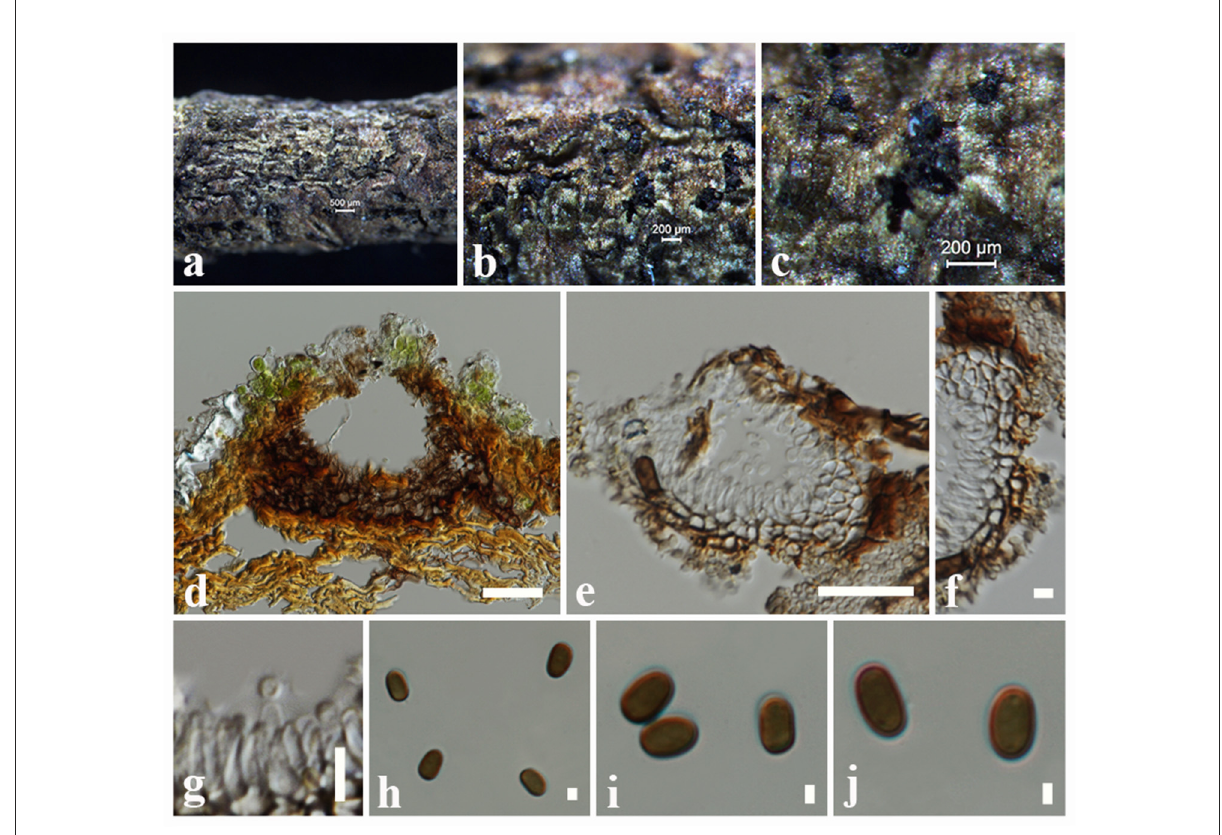
FIGURE5 Paraconiothyrium archidendri (MFLU 18-2653, new host record): (a) Conidiomata on a dead twig of Magnolia sp. (b,c) Close-up of conidiomata on the host. (d,e) Sections through conidiomata. (f) Conidiomatal wall. (g) Conidiogenous cells with developing conidia. (h–j) Conidia. Scale bars: (a) = 500 µ m, (b,c) = 200 µ m, (d,e) = 50 µ m, (f,g) = 10 µ m, (h–j) = 2 µ